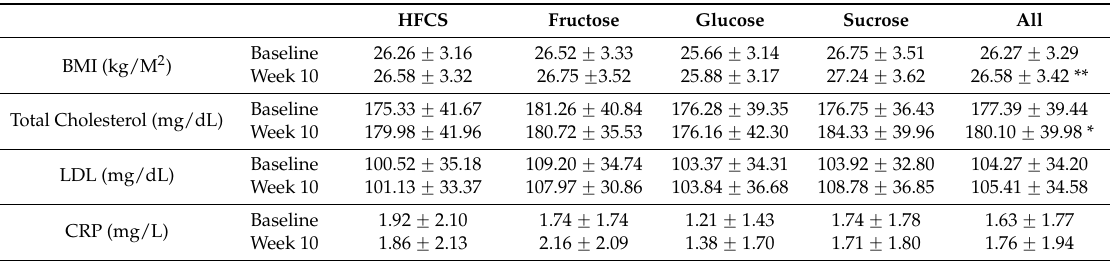
Table 3. The effect of ten weeks of daily consumption on each of 4 different types of sugar on non-ATPIII Cardiovascular Risk